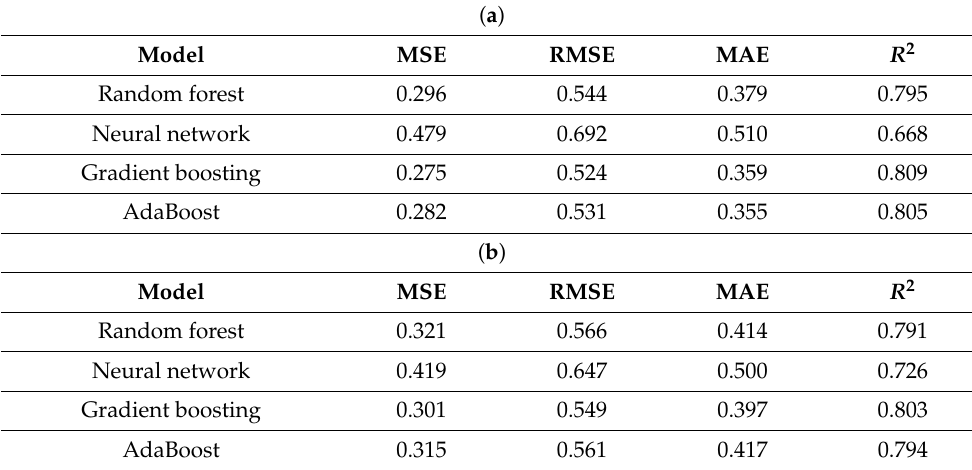
Table 9. ( a ). Result of ML models with training data excluding outliers. ( b ). Result of ML models with testing data excluding